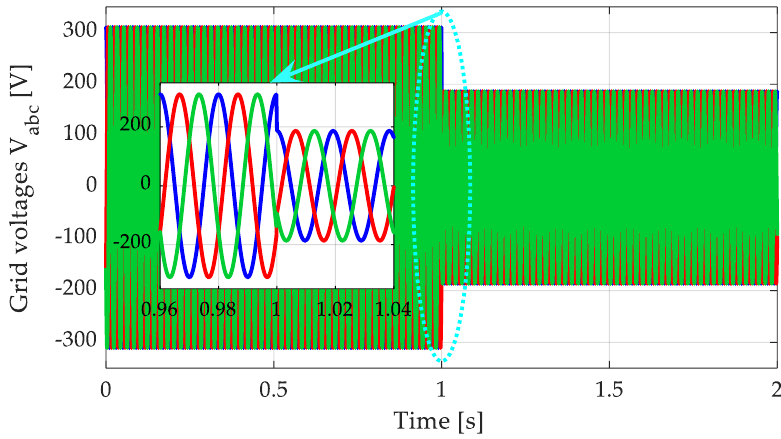
Figure 9. Grid voltages: scenario 1.